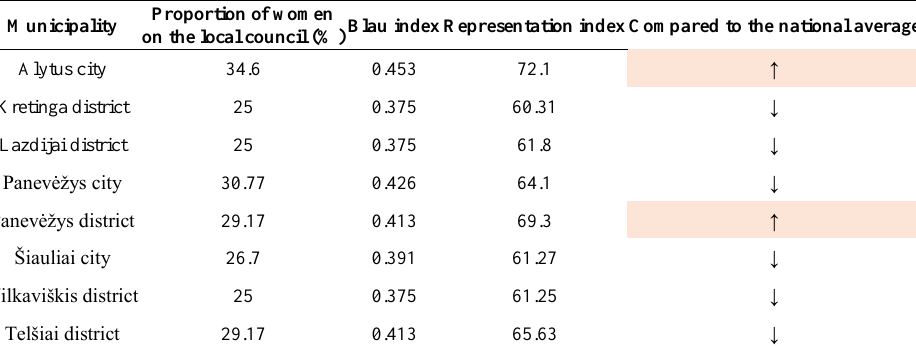
Table 3. Gender representation in municipal councils of Lithuania